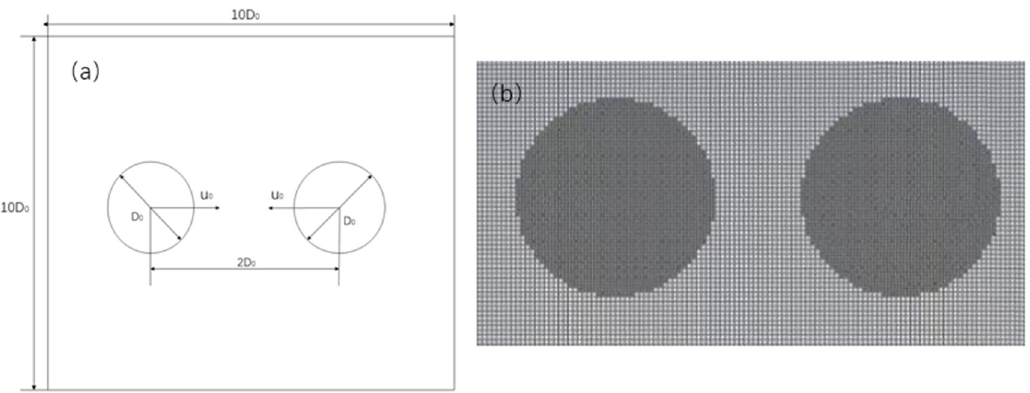
Figure 1. Computational domain ( a ) and the local grids containing the two droplets at the initial time ( b ).